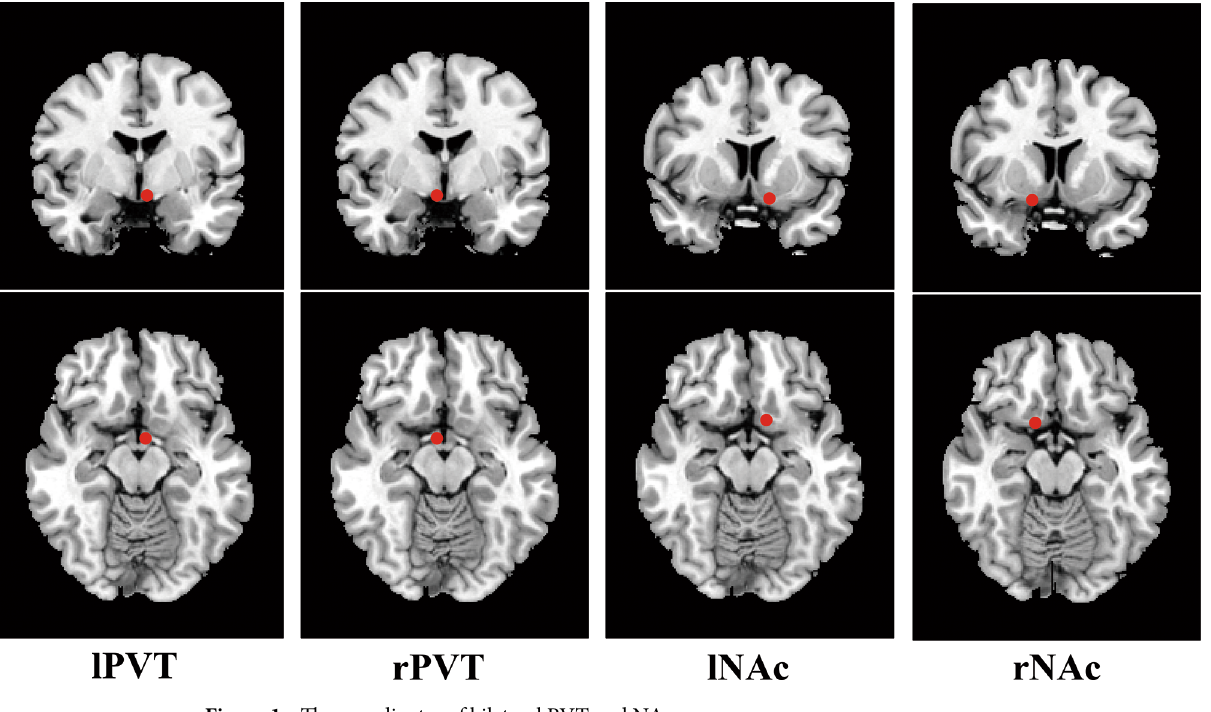
Figure 1. The coordinates of bilateral PVT and